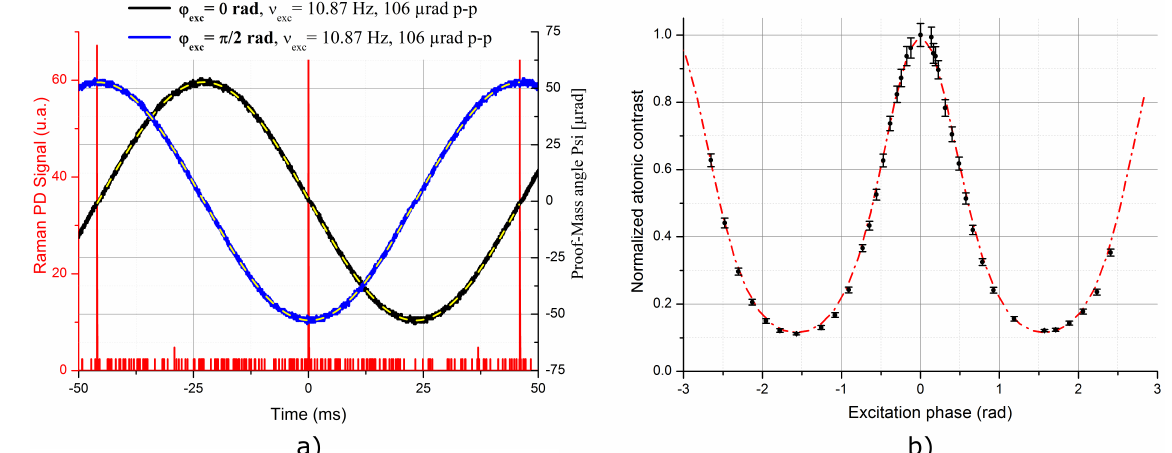
Figure 18. EA’s PM rotation and impact on CAI’s contrast. ( a ) Proof-mass angle Ψ measurement during the interferometer phase delimited by the three laser pulse detected thanks to a photodiode (red signal). The rotation excitation is made at 10.87 Hz with an amplitude of 106 µ rad p-p. Two excitation phases are represented, 0 rad (black) and π /2 rad (blue). The excitation phase is defined relative to the first Raman laser pulse of the CAI. The dashed yellow lines are sine-fitting functions. ( b ) Evolution of the atomic contrast according to the excitation phase for a 10.87 Hz sine excitation of amplitude 106 µ rad p-p. The experimental data are represented in black dots with ± 2 σ error bars. The red dashed line results from a calculation of contrast loss using as inputs the same experimental excitation parameters. The interrogation time of the CAI is T = 46